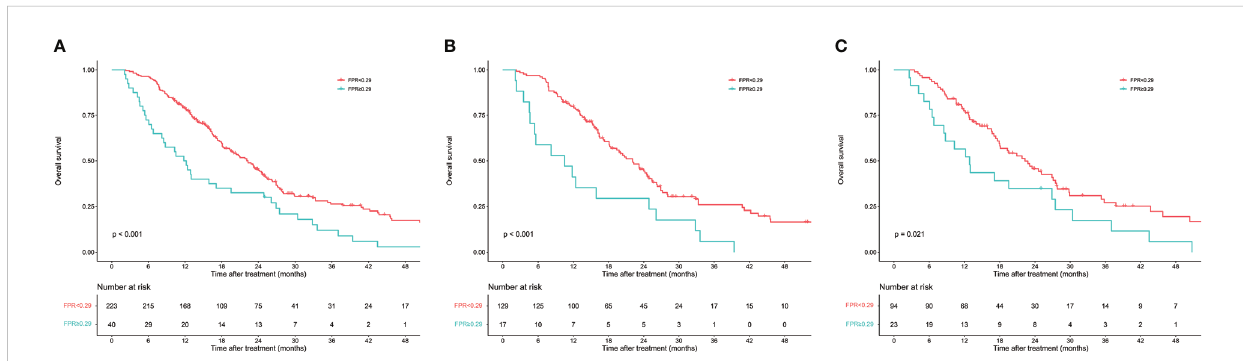
FIGURE 2 Kaplan – Meier curves of overall survival in patients with resectable pancreatic cancer strati fi ed by fi brinogen-to-prealbumin ratio. (A) Total cohort (B) Training cohort (C) Validation cohort.